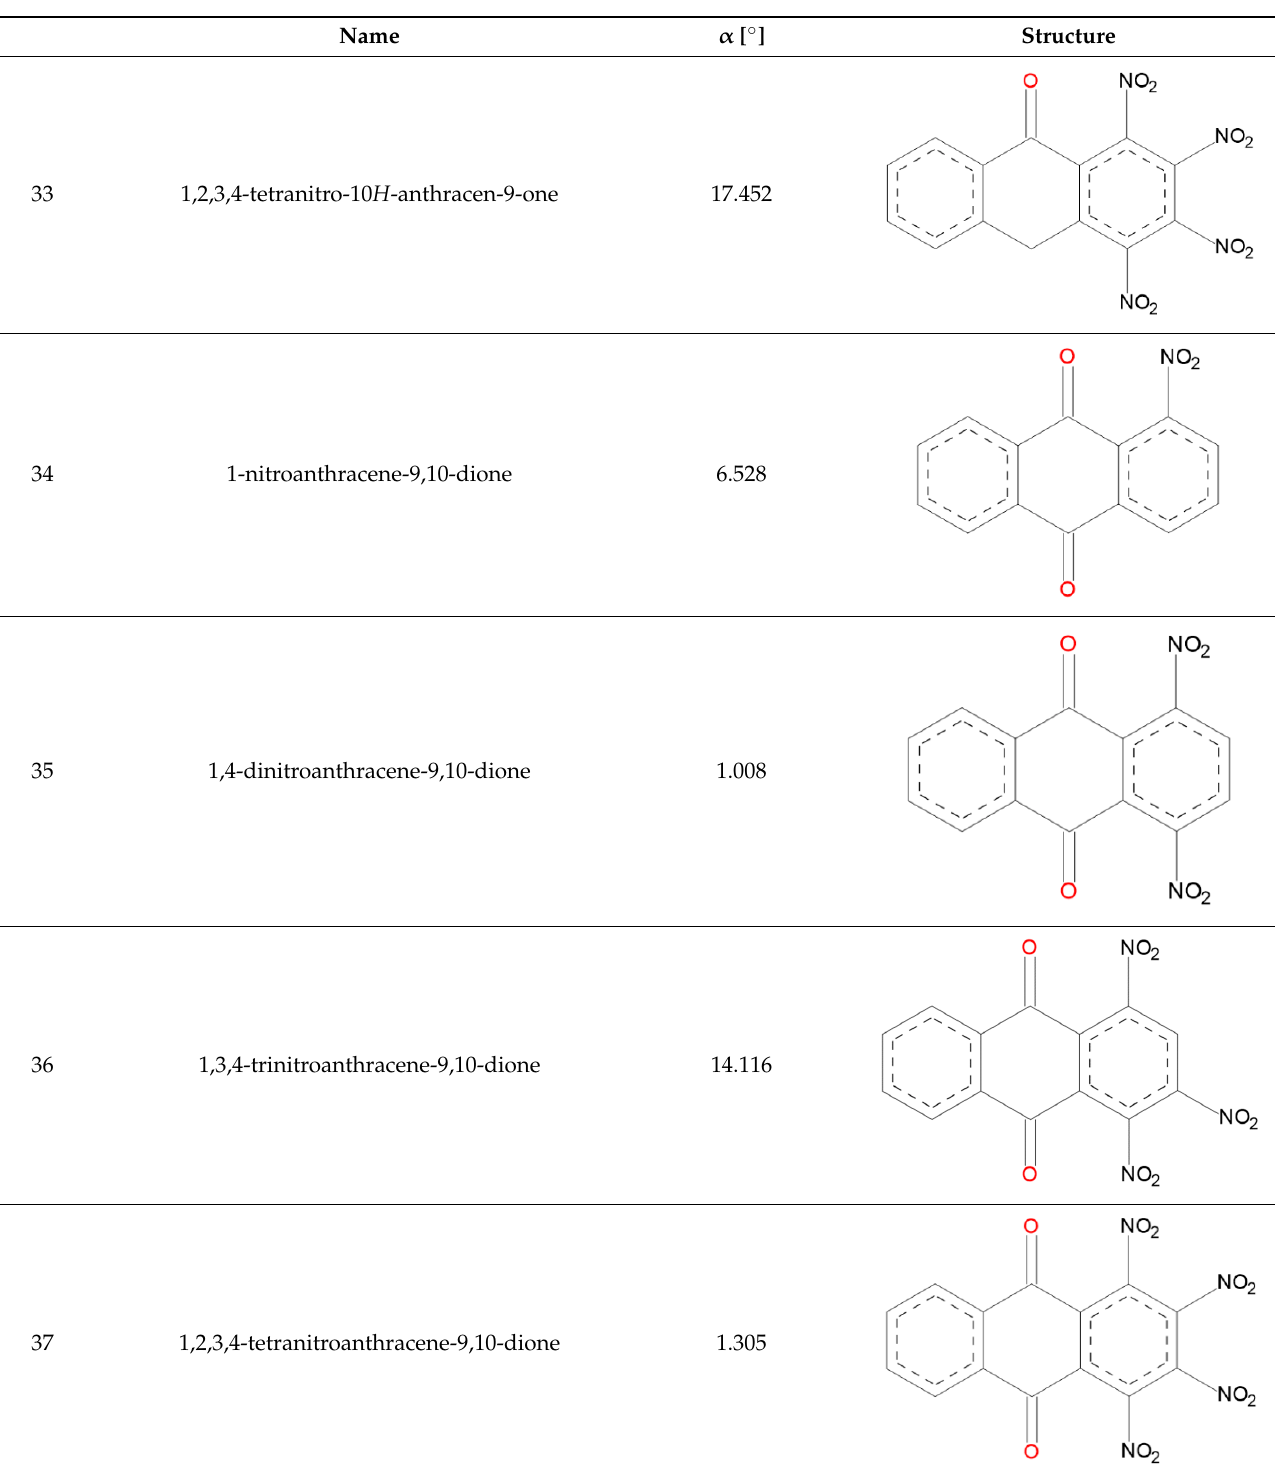
Table 2. β angle and C–N bond length for substituents in the aromatic side ring.